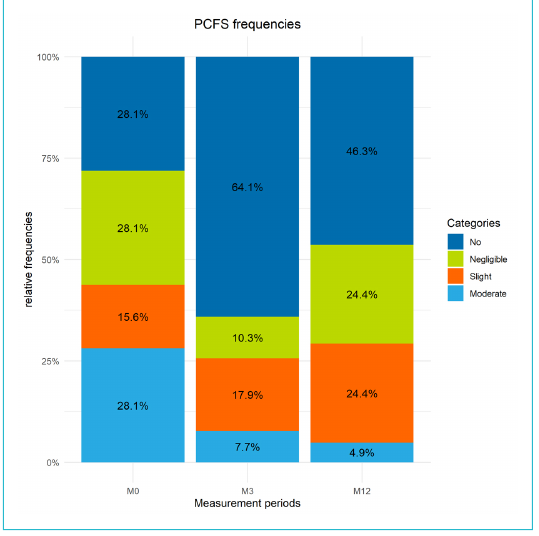
Figure 5: Distribution of categories for perceived limitations in functionality according to the PCFS scale. “No limitations” includes patients with no and negligible limitations on the PCFS scale (no = 0, negligible = 1). Individuals in the “limitations” category scored slight and moderatelimitations on the PCFS scale (2 = slight, 3 = moderate). The score “5 = dead” was not